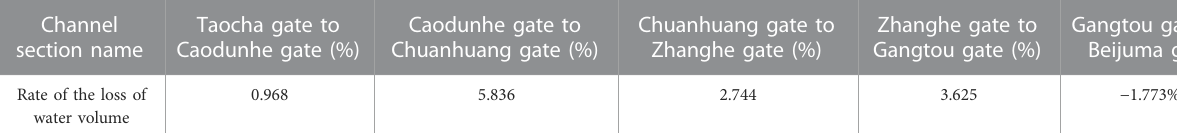
TABLE 4 Loss of water volume rate of fi ve canal sections in the middle route of the SNWDP. Channel section name